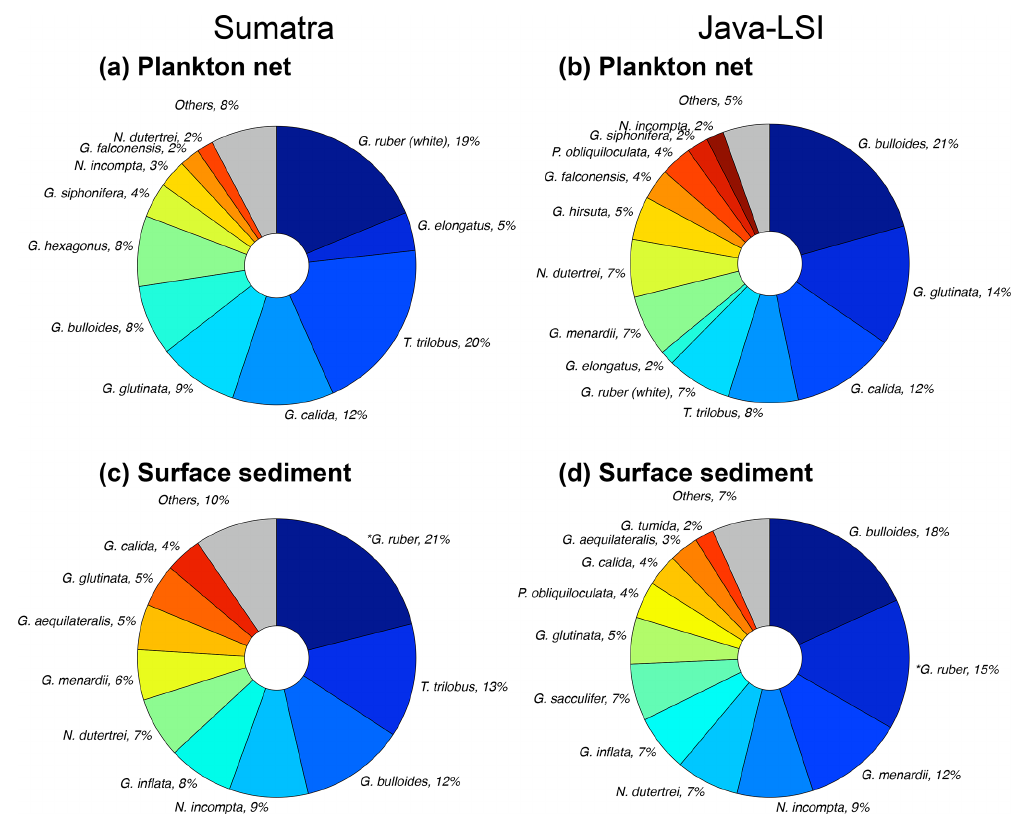
Figure 7. Planktic foraminiferal assemblage in samples of (a, b) plankton nets (this study) and (c, d) surface sediments (data from Mohtadi et al., 2007) off Sumatra (transect 1–3) and off Java–LSI (transect 5–7). Mohtadi et al. (2007) did not differentiate between morphotypes; * G. ruber data comprise both morphotypes ( G. ruber (white) + G. elongatus ). Note that G. ruber (white) and G. elongatus data from plankton nets are plotted side by side to facilitate visual comparison with * G. ruber in sediment